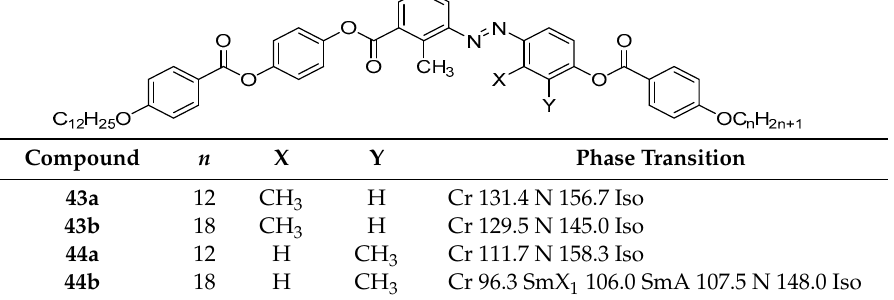
Table 10. Phase transition of compounds 45 and 46